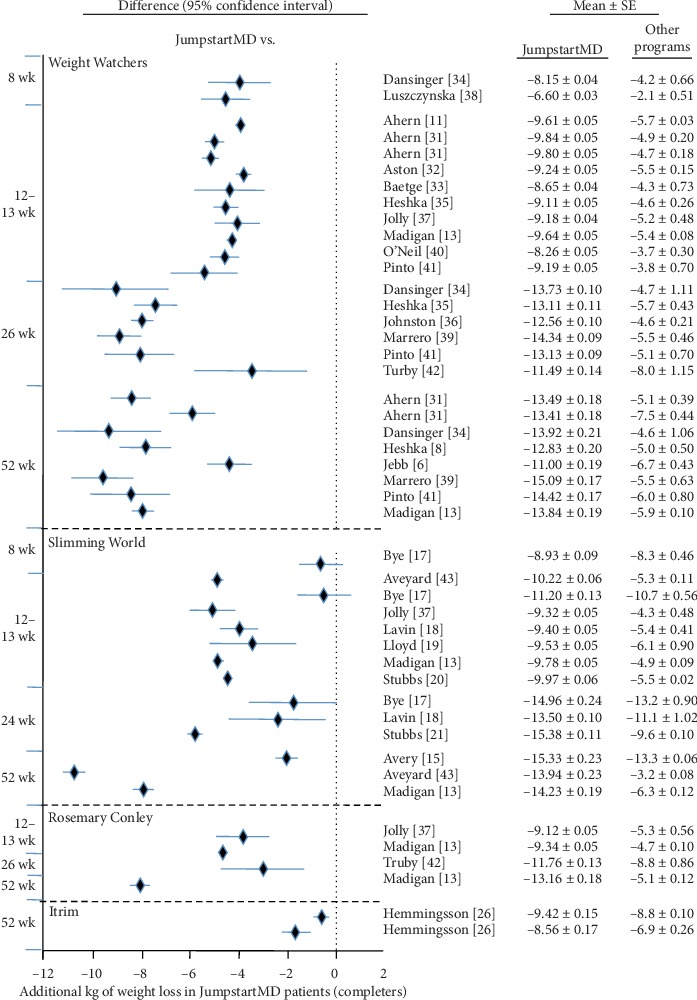
Mean weight loss difference between JumpstartMD and other commercial programs in completers as measured by kg weight loss. Negative differences designate greater JumpstartMD weight loss. See legend to Figure 5 for further explanation.